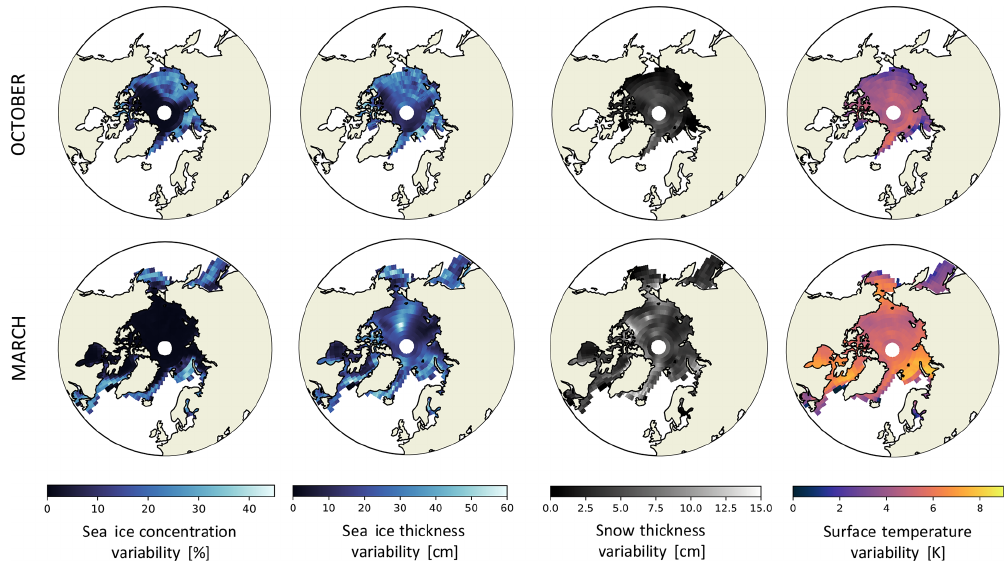
Figure B1. Time mean of the standard deviation for each date over a sample of five years (2003 to 2008) for each variable and each grid cell. This standard deviation was the variability estimate used to modulate the input variables in the sensitivity studies of Sect. 4.3.2. These values are inferred from the SICCI2 assimilation